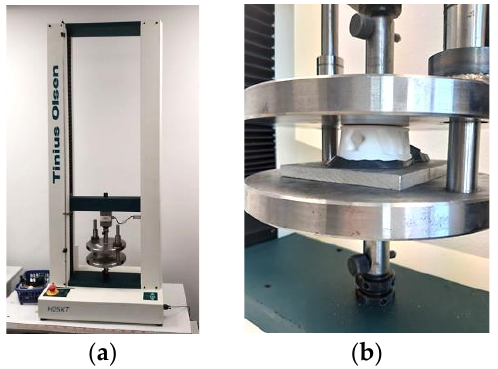
Figure 4. Compression test equipment: ( a ) universal testing machine Tinius Olsen H25KT; ( b ) special compression supplement.